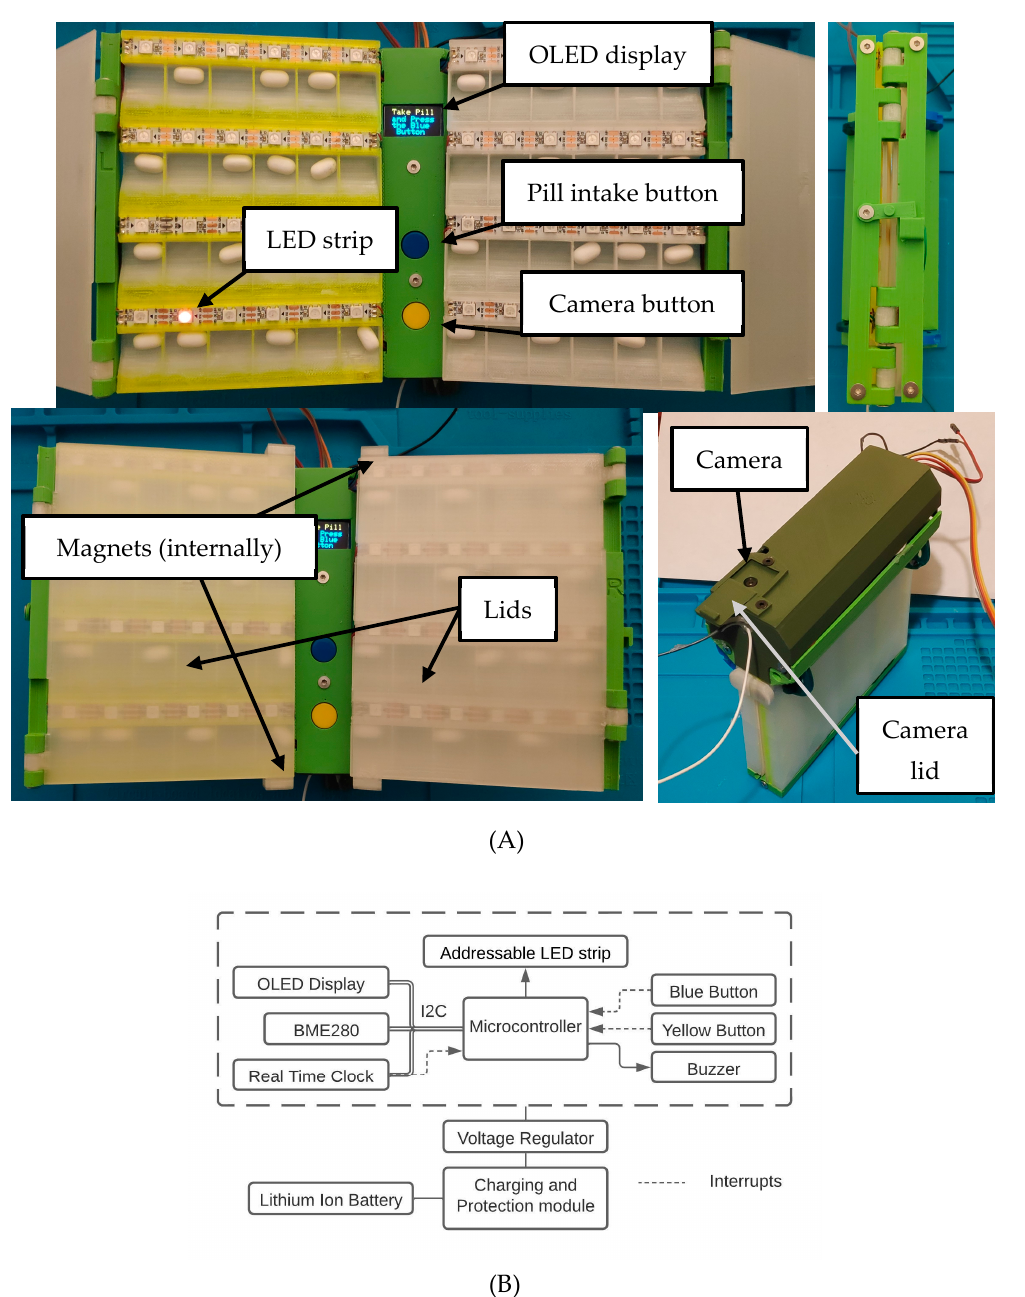
Figure 2. ( A ) 3D-printed pillbox: top-left: unfolded structure, top-right: completely folded structure, bottom-left: folded lids, bottom-right: rear view. ( B ) Simplified pillbox hardware architecture. OLED display, BME280, and real-time clock communicate with the microcontroller using the I2C protocol. The blue and yellow buttons and the real-time clock operate as interrupts. (Figure 2B created in Lucidchart. Available: